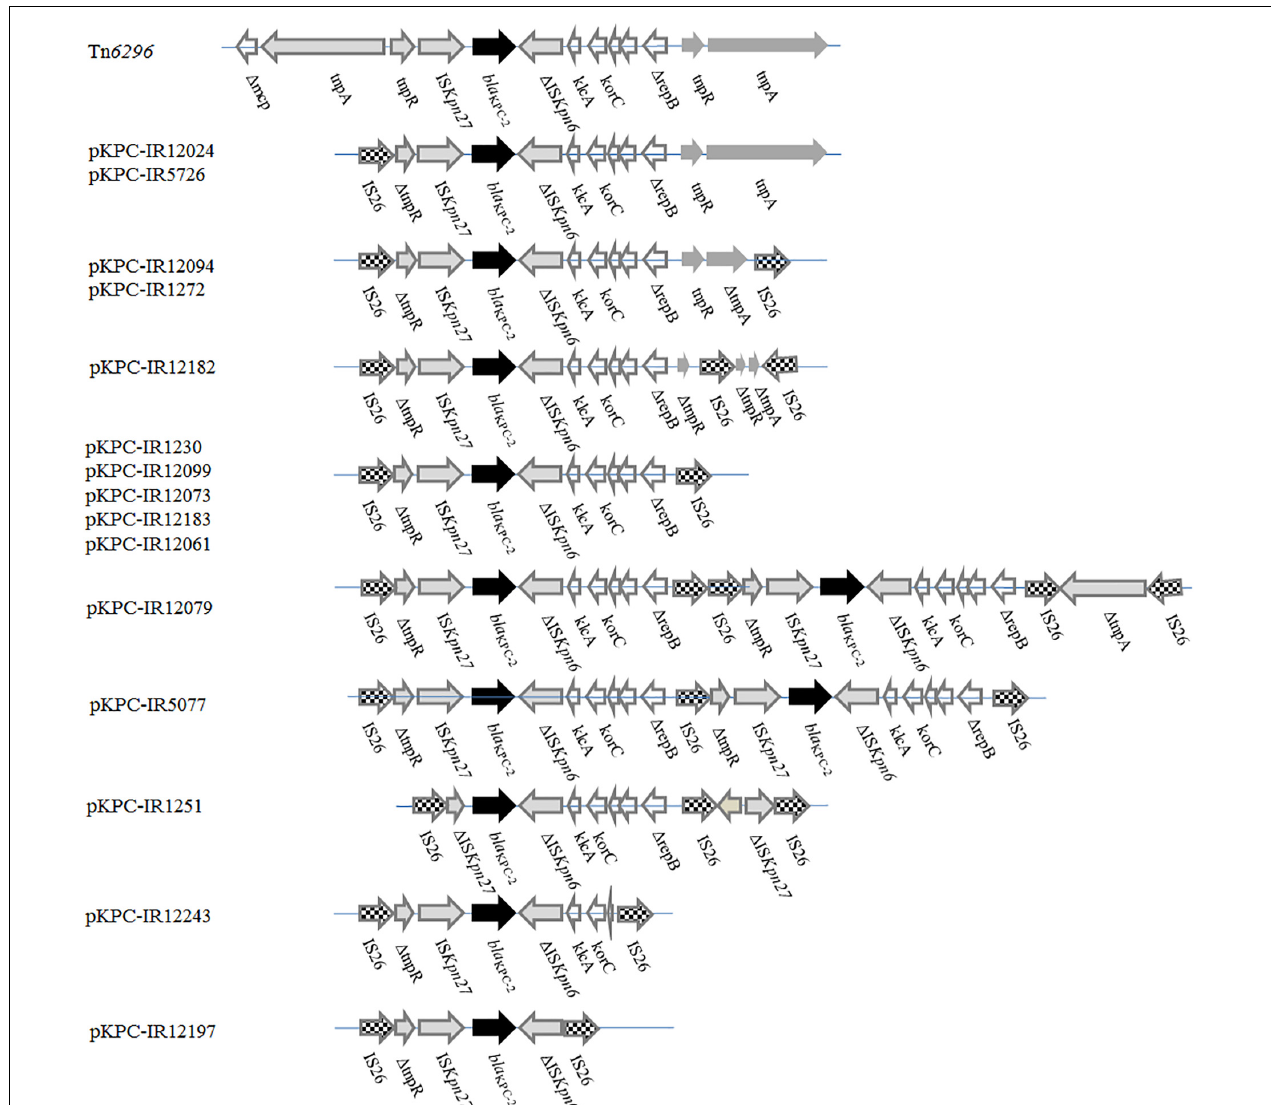
FIGURE 4 | Linear comparison of bla KPC − 2 genetic surroundings between the 15 plasmids. Genes are denoted by arrows. Resistance genes, mobile elements, and other features are shown based on functional classification. Two copies of the IS 26 - (cid:49) tnpR-IS Kpn27 - bla KPC − 2 -IS Kpn6 -klcA-korC- (cid:49) repB-IS 26 units are arranged in tandem in pKPC-IR12079, while in pKPC-IR5077 sharing one IS 26 at the connection. TABLE 2 | Characteristics of virulence plasmids. Strain